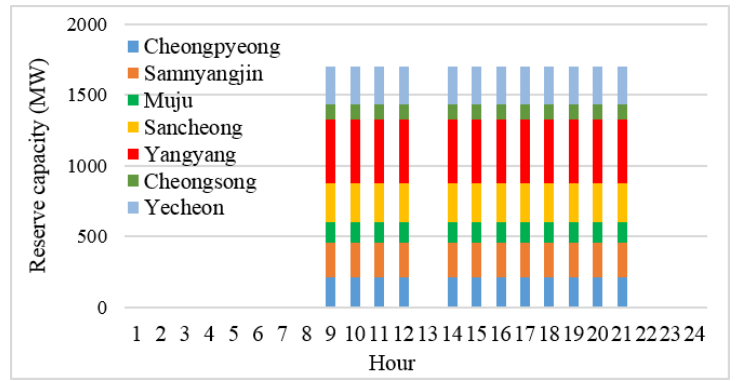
Figure 3. RCP i,t using the uniform allocation method for 2016.